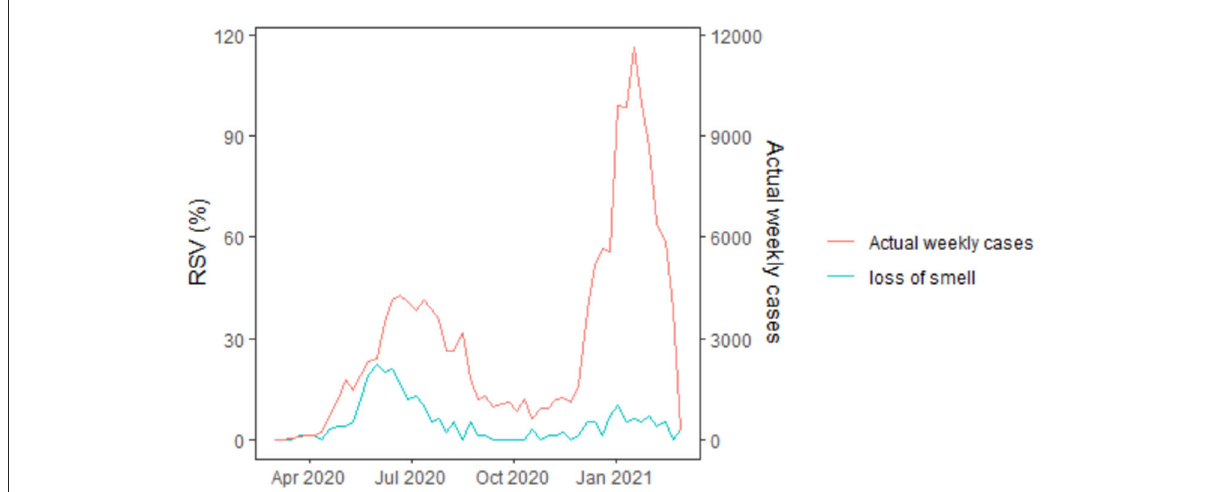
FIGURE3 Time plot of weekly GT RSVs of “loss of smell” search term (the most strongly correlated) and the COVID-19 weekly cases in Nigeria. GT RSVs, Google Trends Relative Search Volumes.